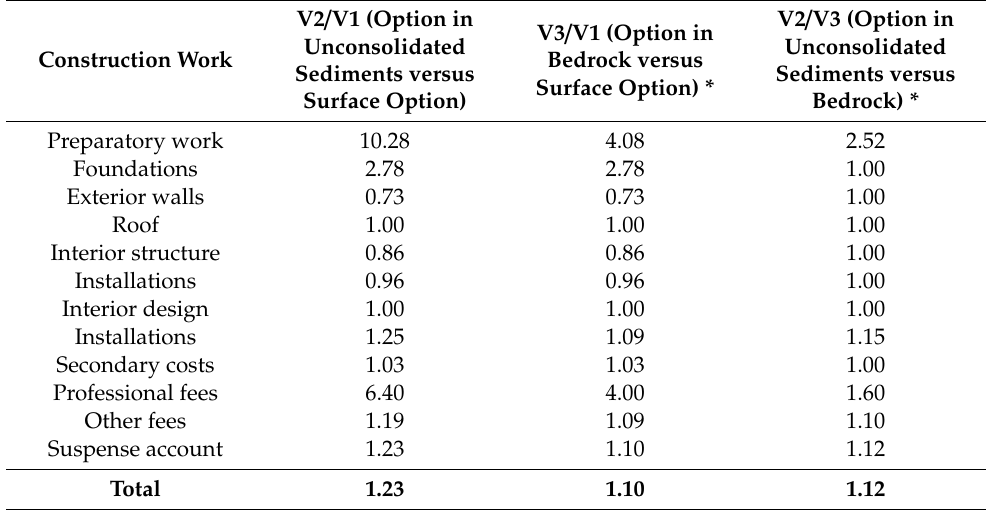
Table 4. Relative cost comparison between estimated construction costs of the three